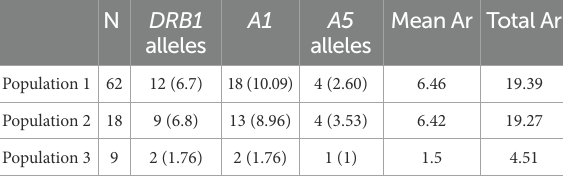
TABLE 1 MHC allele diversity and allele richness per reindeer